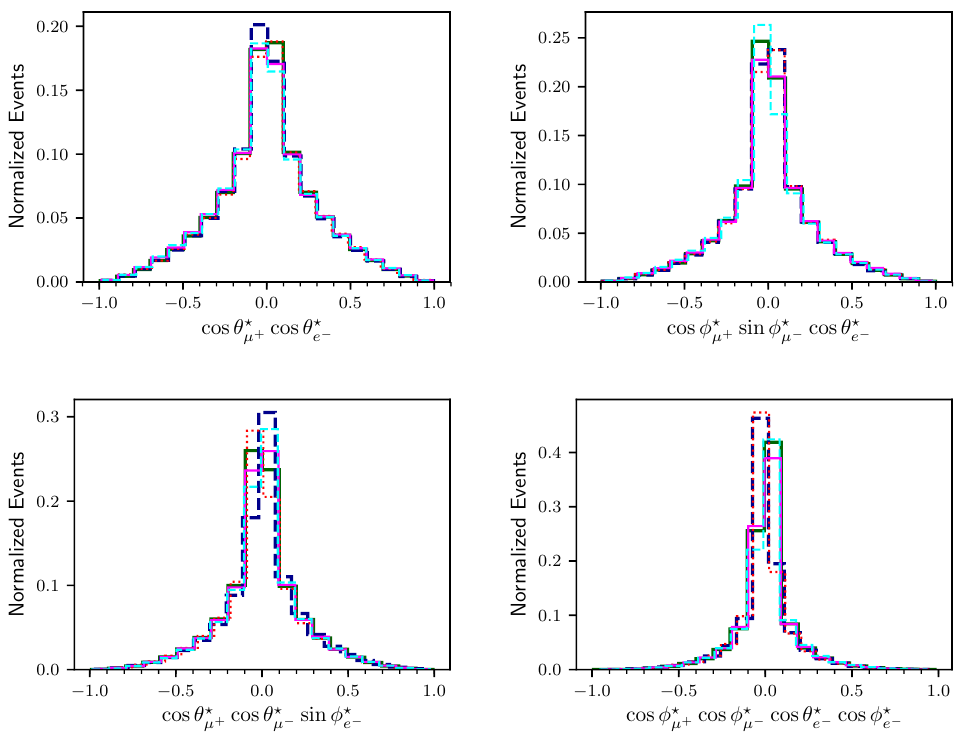
Figure 6 . Normalized distributions of angular functions for two-body and three-body spin corre- lations ( pp tZ in left-top , ppp t ¯ tZ in right-top , ppp t ¯ tZ in left-bottom , and ppT t ¯ tZ in right-bottom zz xyz zzy xx ( xz ) panel) in the rest frame of t , ¯ t and Z for SM and few benchmark anomalous t ¯ tZ couplings with the legends same as in figure